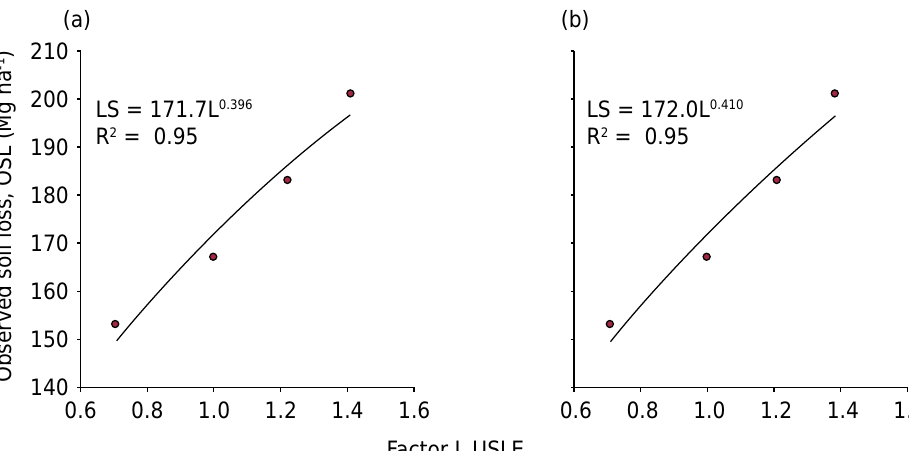
Factor Figure 4. The relation between values of total soil loss (SL) observed in each treatment and the values of the L factor (a) of the USLE and (b) of the RUSLE (average of replicates).